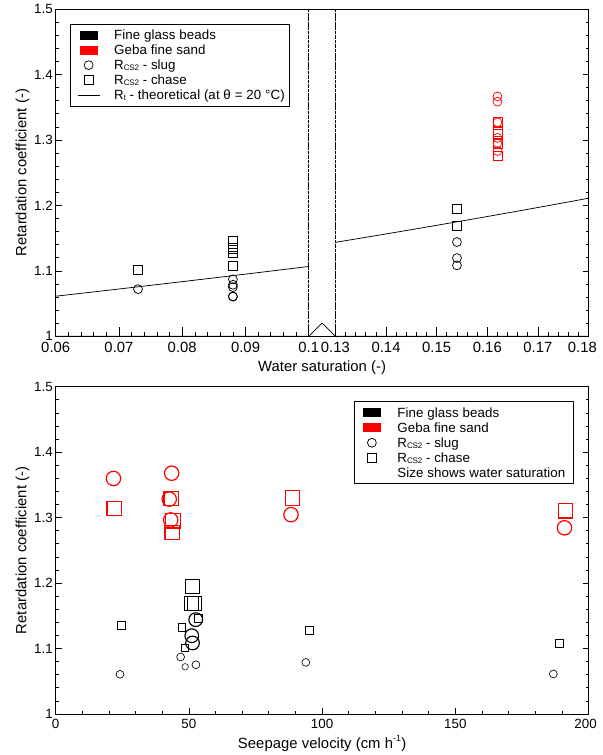
Figure 8. Retardation coefficients of CS 2 determined from exper- iments with different seepage velocities in fine glass beads and in Geba fine sand at different water saturations (evaluated with temporal-moment